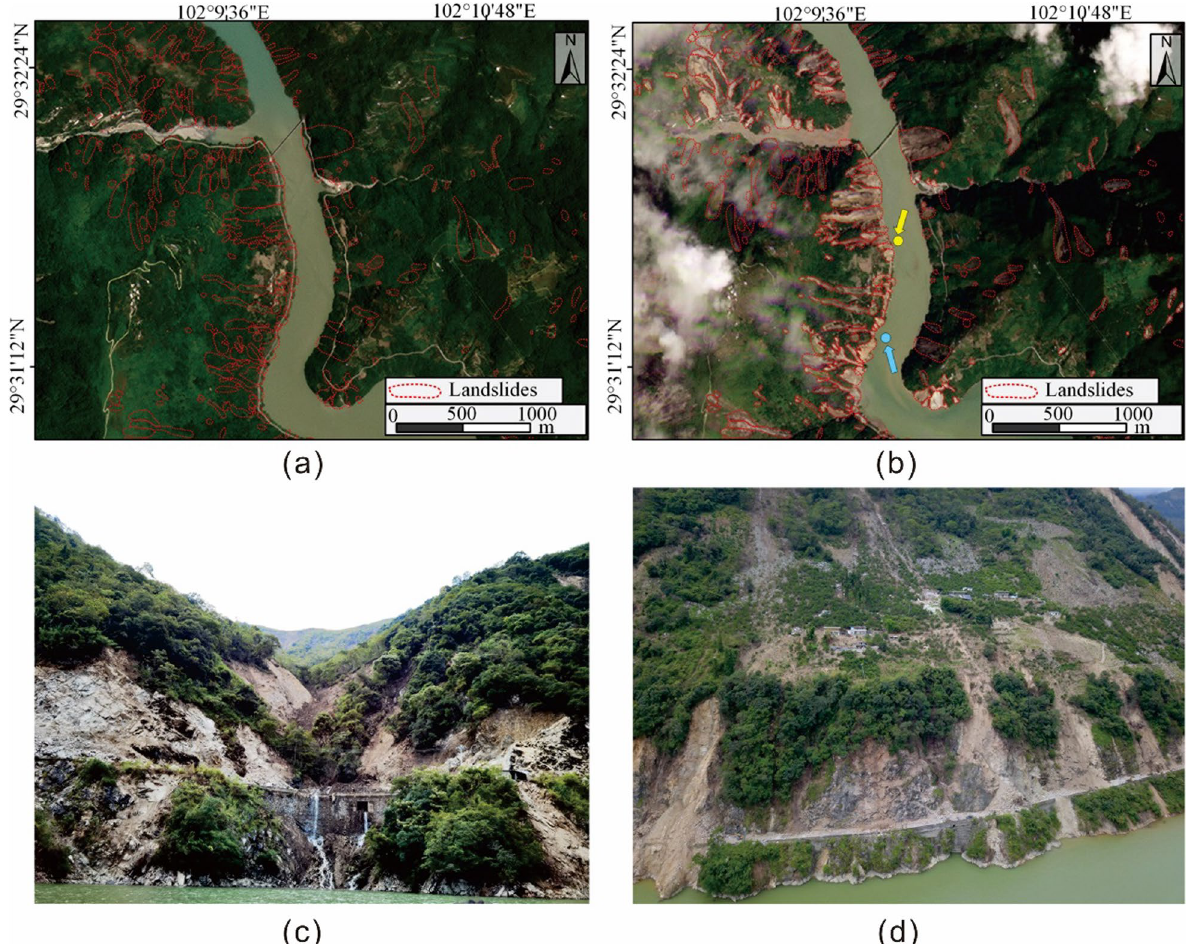
Fig. 2 Remote sensing image of landslide area before and after earthquake and field photos. a And b are the pre and post-earthquake images of the same area (Planet Team 2022). c And d are field photos of the yellow and blue mark positions in ( b ),